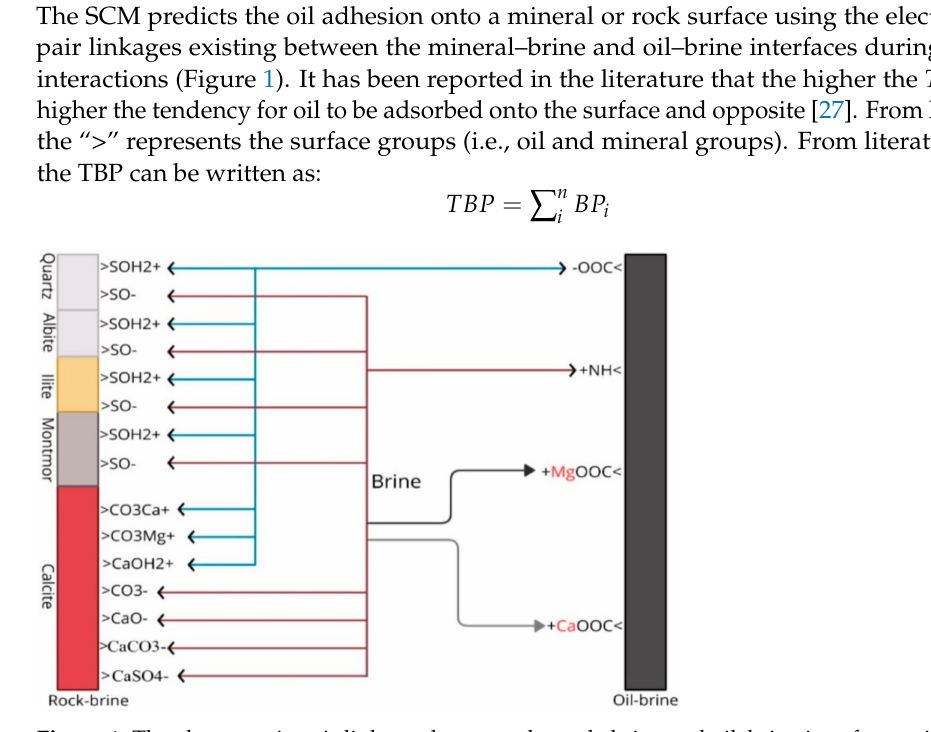
Figure 1. The electrostatic pair linkages between the rock–brine and oil–brine interfaces with unlike charges are given. Direct adsorption of carboxylate (>COO-) onto the positive mineral sites (>SOH 2+ , >CO 3 Ca + , >CO 3 Mg + , and >CaOH 2+ ) can lead to oil adsorption [37]. The surface-active components in the crude oil were depicted by their respective acidic (>COOH) and basic oil (>NH + ) groups, while the minerals (rocks) were represented by their mineral sites (e.g., >Si-O-H, >CO 3 H, and >CaOH). The oil surface reactions